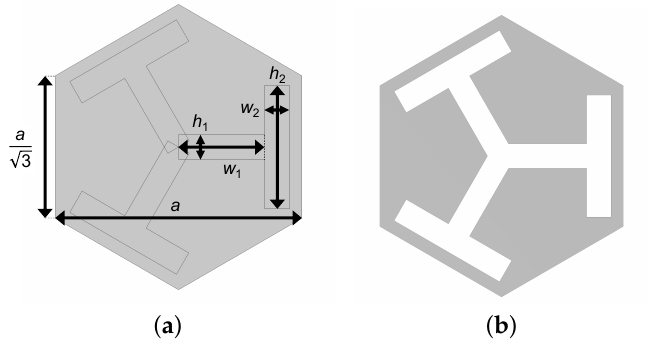
Figure 2. ( a ) Design parameters of the metamaterial unit cell. a indicates the lattice constant, i.e., the pitch between adjacent identical patterns, and w 1 , h 1 , w 2 , and h 2 label the widths and heights of two distinct rectangular slots. The cut area was obtained by C 3 cyclic duplication of the rectangular slots. ( b ) A sketch showing the machined pattern of the unit